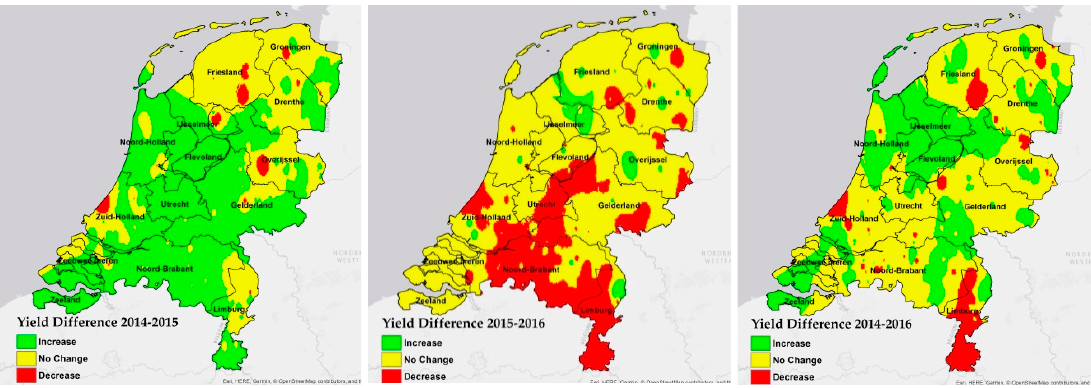
Figure 9. Specific yield difference maps for 2014–2016 for the Netherlands.